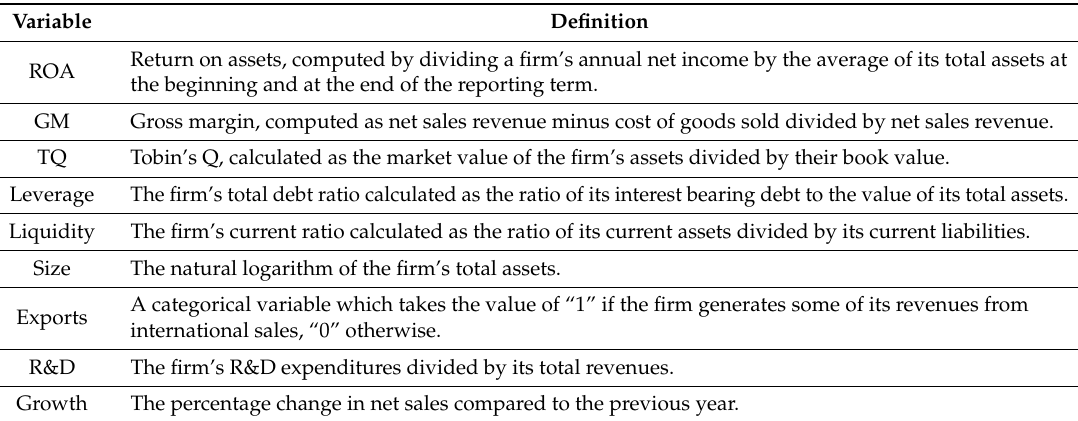
Table 1. Calculation methodology for the